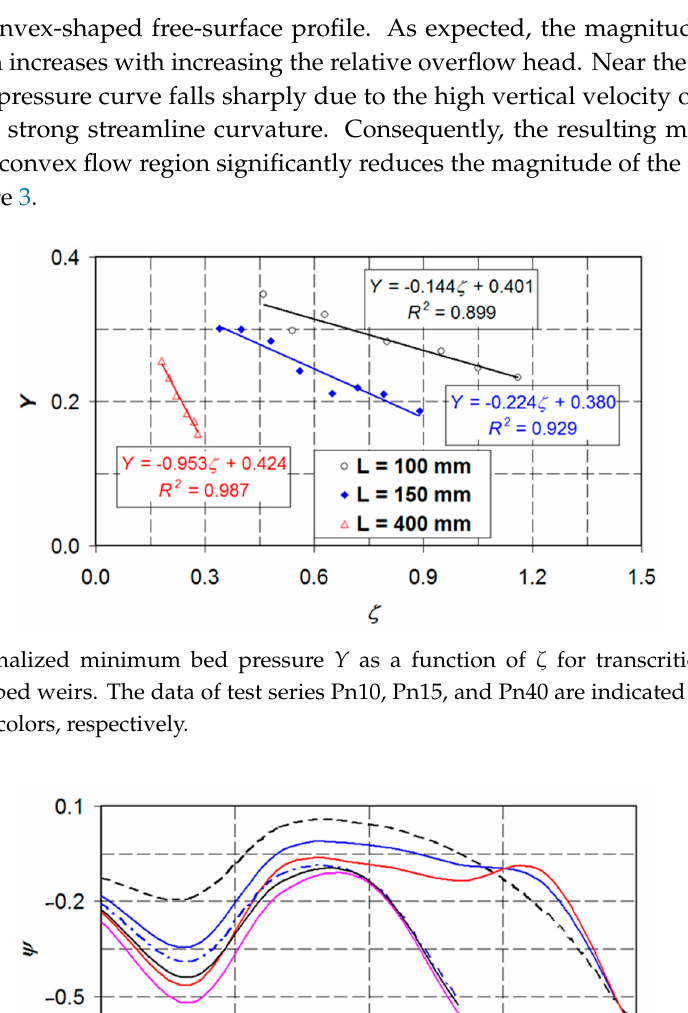
Figure 5. Streamwise variation of the normalized dynamic bed pressure ψ ( X w ) for various values of relative overflow head ζ . The computed profiles are based on the experimental data of series Pn10 and Pn15.